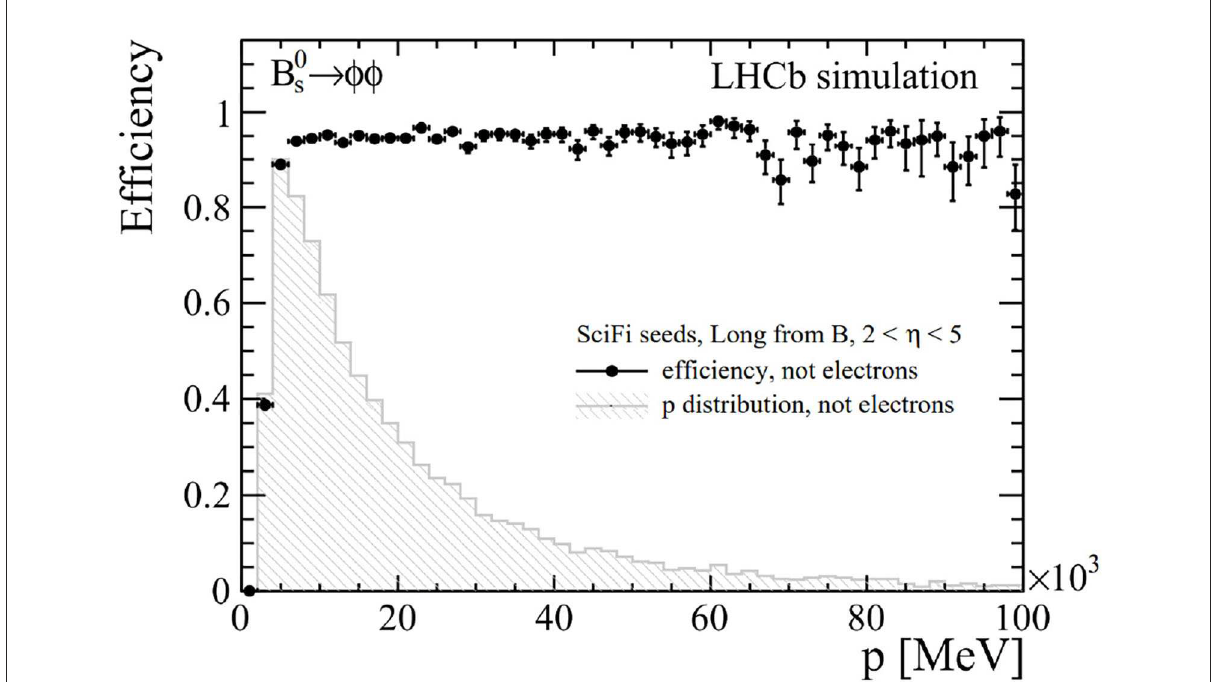
FIGURE7 Efficiency of the Hybrid seeding reconstruction on GPUs as a function of the track momentum of Long tracks produced from B s